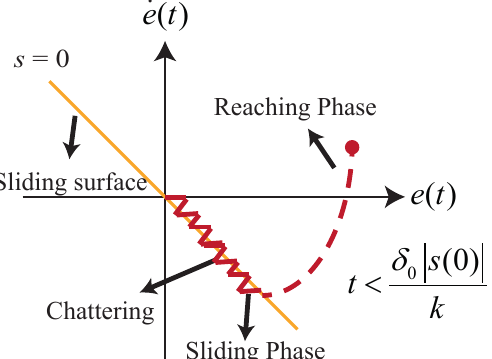
Figure 3. Sliding phase mechanism of the